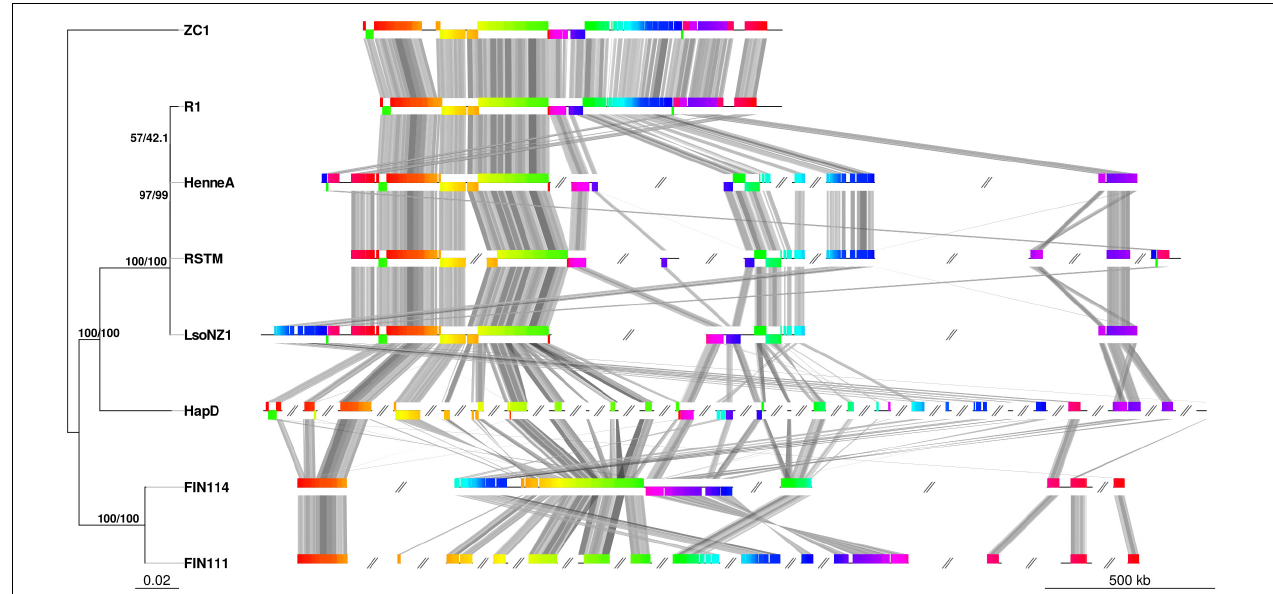
FIGURE 2 | Unrooted maximum likelihood phylogenetic tree based on SNPs shared between Lso haplotypes (left) and synteny blocks common to all the haplotypes (right). Bootstrap (left) and SH-aLRT (right) support values are plotted at each node. Colors of syntenic blocks are in accordance with their position in the reference genome (ZC1). Colors are maintained across genomes and are connected by gray lines. Gray double slash denotes contigs. R1 was plotted as a concatenated set of contigs. Only contigs with common blocks are plotted in the other genomes.